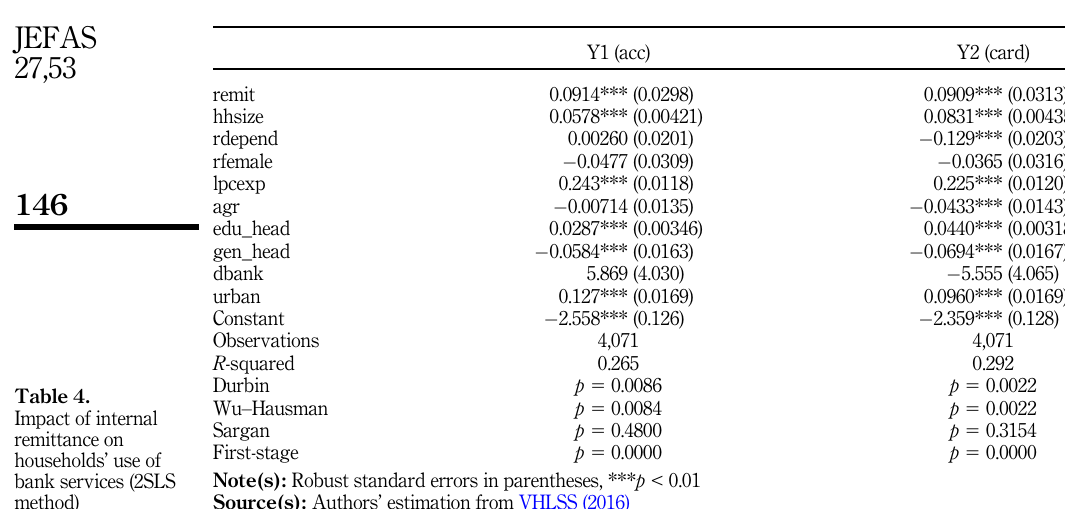
Table 4. Impact of internal remittance on households ’ use of bank services (2SLS